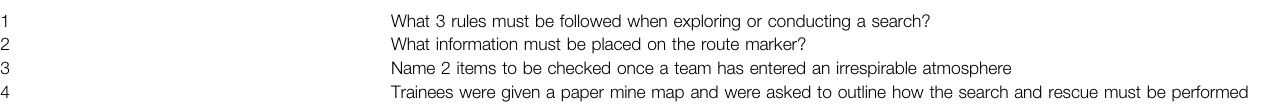
TABLE 3 | Skill test questionnaire. Q1 What 3 rules must be followed when exploring or conducting a search? Q2